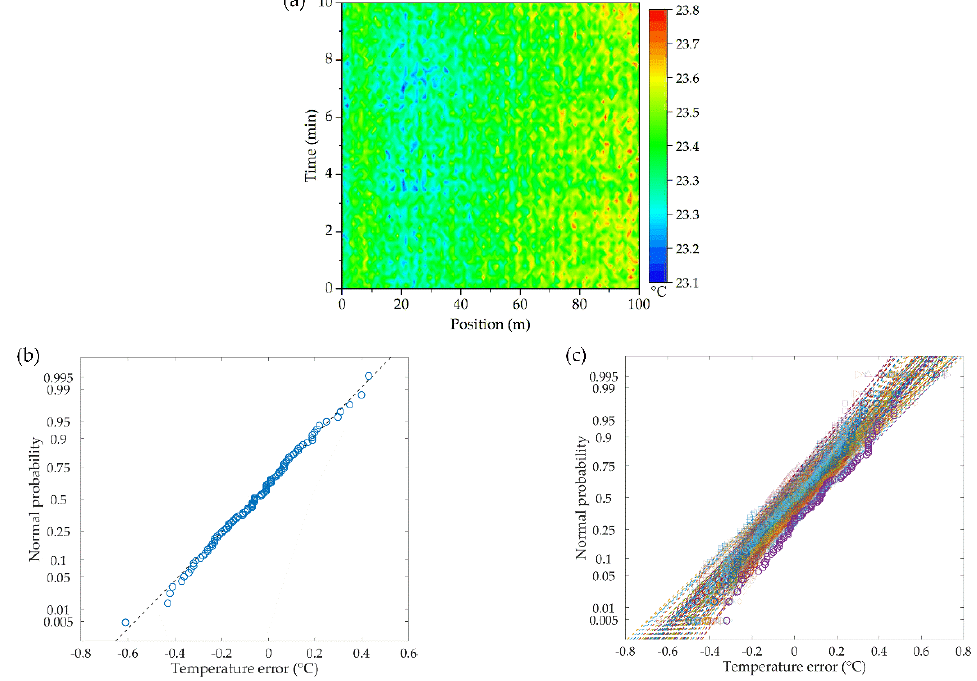
Figure 6. ( a ) Temperature noises; and probability plot for normal distribution of the sensing errors ( b ) At 1min; ( c ) Throughout the whole time.